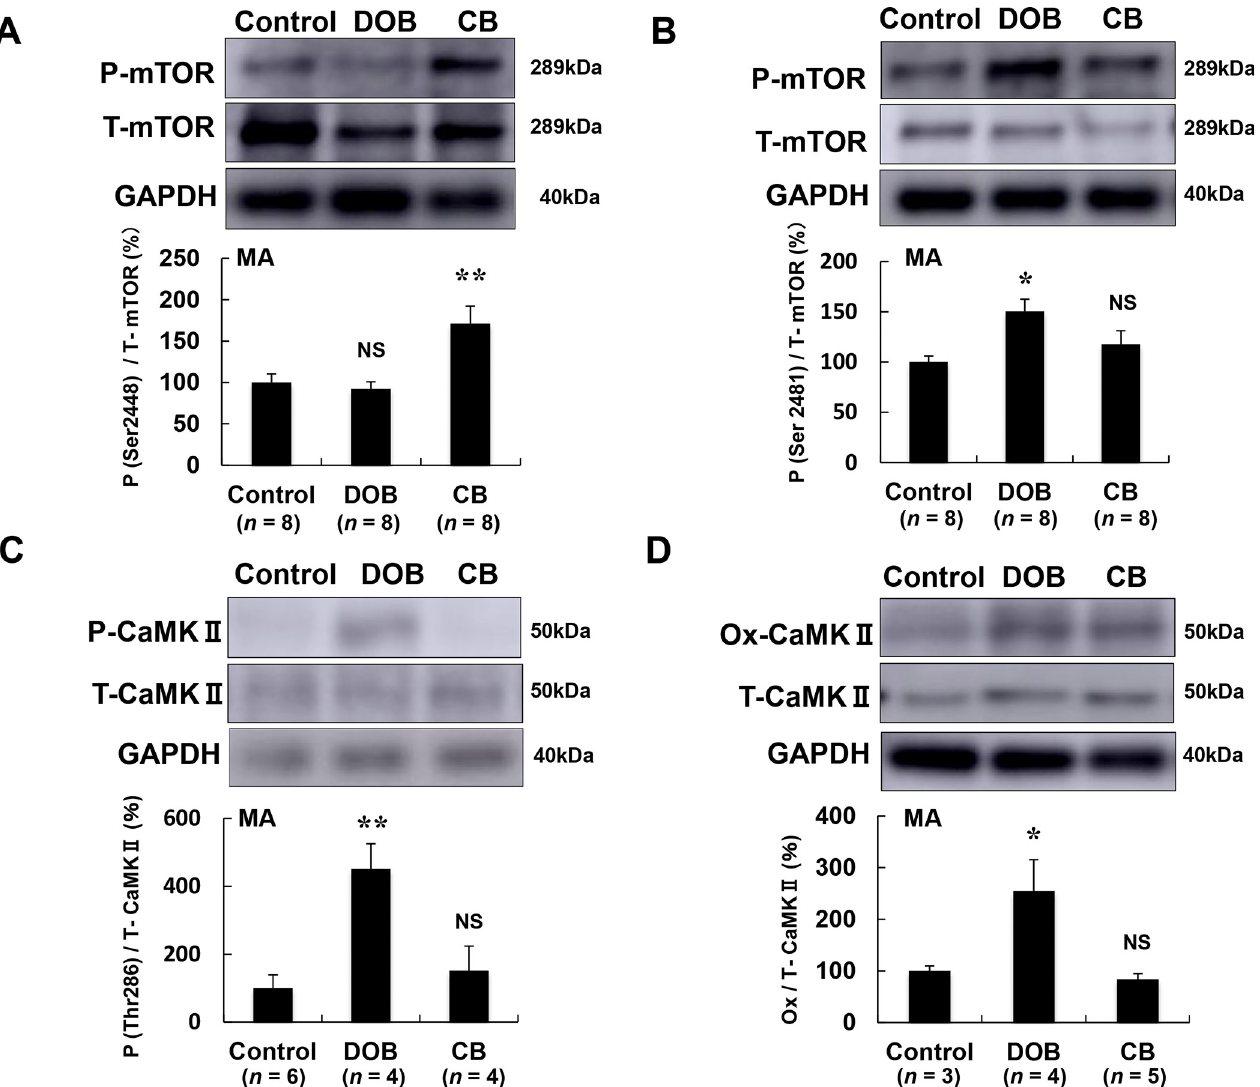
Fig 6. Effects of DOB and CB on mTORC1/C2 and CaMKII signaling pathways in masseter muscle. (A) In masseter muscle, mTOR phosphorylation on serine 2448, a specific marker of mTORC1 formation, was significantly increased in the CB group ( �� P < 0.01 vs. Control), but not in the DOB group in masseter muscle. (B) mTOR phosphorylation on serine 2481, a specific marker of mTORC2 formation, was significantly increased in the DOB group ( � P < 0.05 vs. Control), but not in the CB group in masseter muscle. (C-D) CaMKII phosphorylation was significantly increased in the DOB group ( �� P < 0.01 vs. Control), but not in the CB group (C) . CaMKII oxidation was also significantly increased in the DOB group ( � P < 0.05 vs. Control), but not in the CB group (D) . MA; masseter muscle.